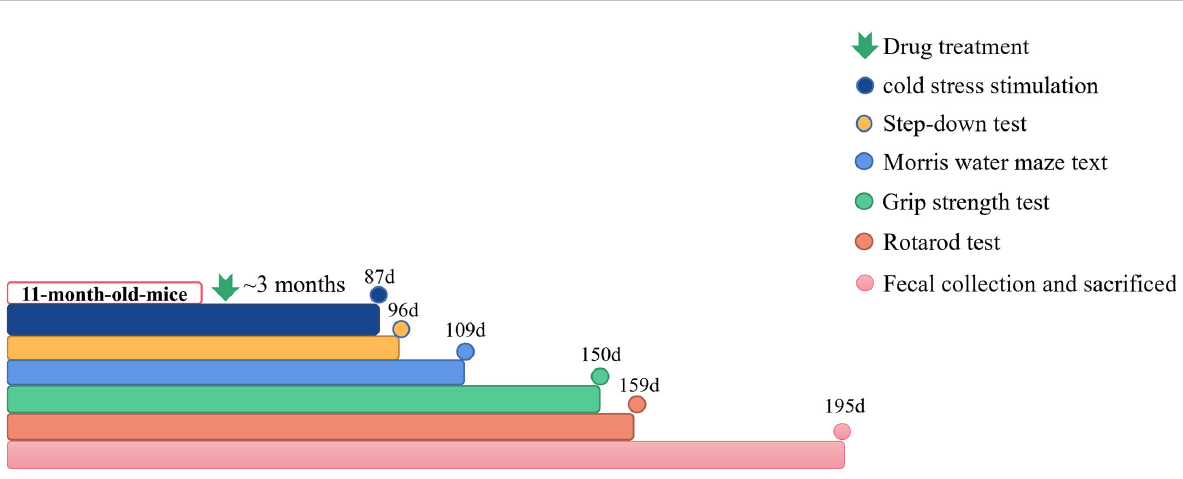
FIGURE 1 The work fl ow of animals and drug administration. Cold stress stimulation: n=3~8; Step-down test: n=3~8; Morris water Maze test: n=3~8; Grip strength test: n=3~8; Rotarod test: n=3~8; Fecal collection and sacri fi ced: